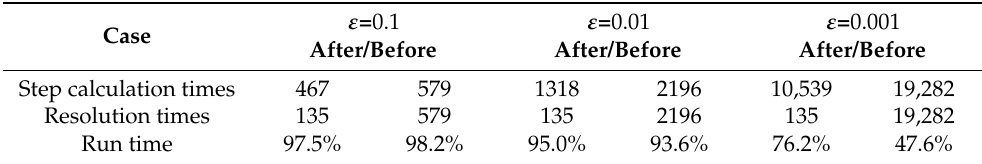
Table 4. Comparison of the C11 satellite visibility solving